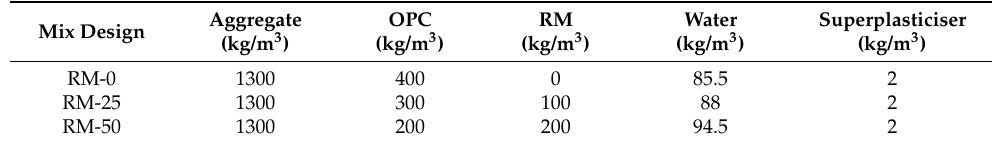
Table 2. Compositions of prepared pervious